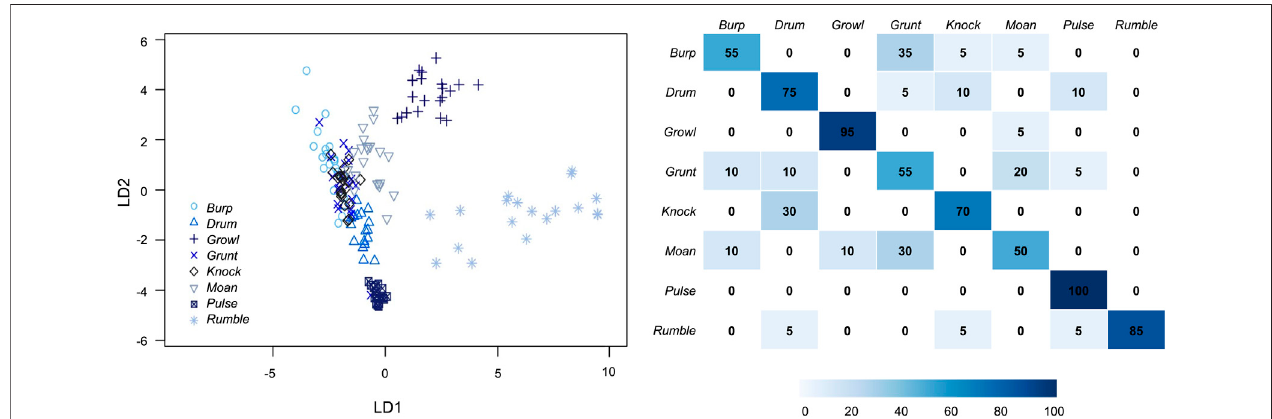
FIGURE 6 | Discriminant function analysis scatterplot (left) and cross-validated DFA matrix (right) for the eight call types produced under water by male spotted seals ( n = 20 for each call type). Seventeen acoustic parameters were included in the DFA (see Table 1 ). LD1 was most strongly correlated with 90% call duration and explained 51% of the total variance. LD2 was most strongly correlated with aggregate entropy and explained 32% of the total variance. The cross-validated DFA classi fi cationmatrix(right)showsthepercentofcorrectlyclassi fi edcallsbytype,withdarkercolorsindicatinghigher correctclassi fi cationrates.Theeightcalltypes were accurately classi fi ed by the cross-validated DFA at a signi fi cantly higher rate than would be expected by chance (12.5%).